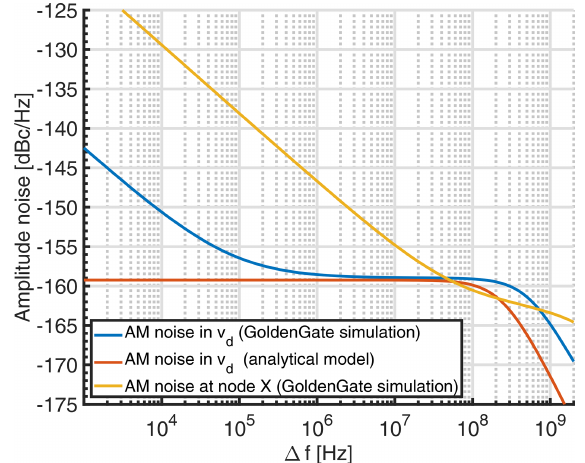
Figure 9. Measured spectrum of a DPPH sample of a volume of approximately 3pL. The spectrum was acquired using the setup of Fig. 1b by sweeping the tuning voltage of the VCO through the res- onance frequency and simultaneously applying a small sinusoidal signal for a subsequent lock-in